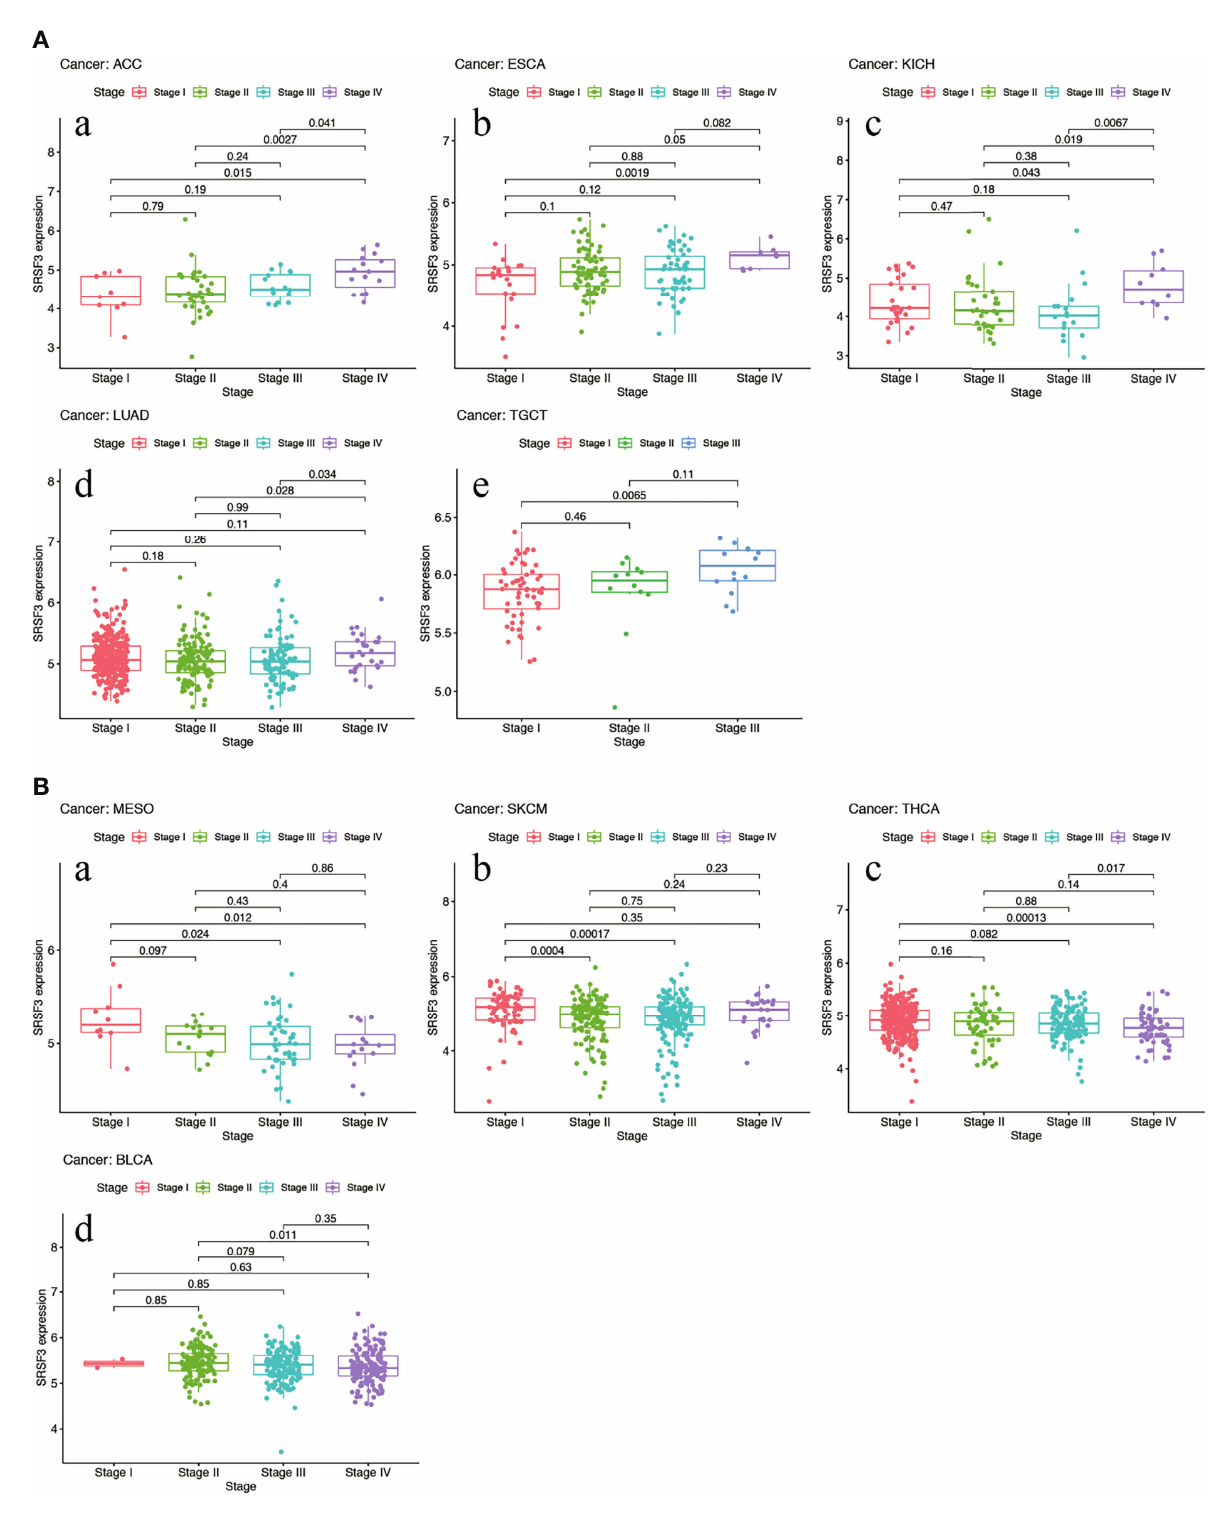
FIGURE 2 | High expression of SRSF3 correlates with advanced TNM stage in human cancer. (A) Expression of SRSF3 is higher in more advanced TNM stage in ACC (a) , ESCA (b) , KICH (c) , LUAD (d) and TGCT (e) . (B) Expression level of SRSF3 is lower in more advanced TNM stage in BLCA (a) , MESO (b) , SKCM (c) and THCA (d) . P < 0.05 is considered to be statistically signi fi